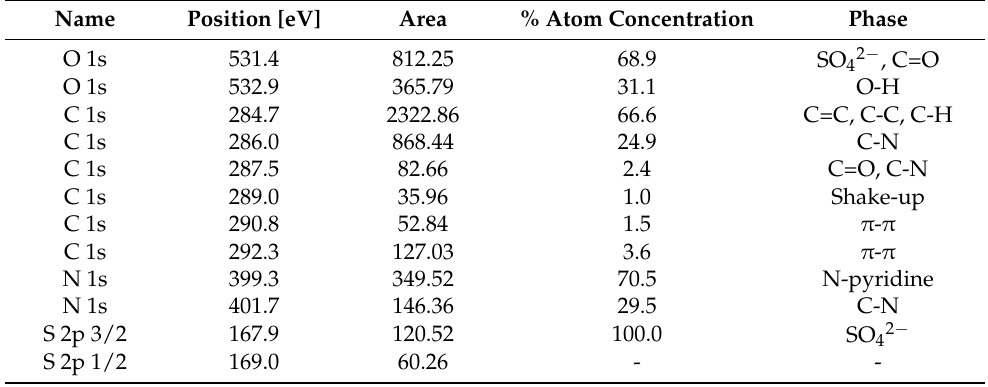
Table 7. The XPS analysis results obtained in the narrow range of binding energy for the Dowex M 4195.